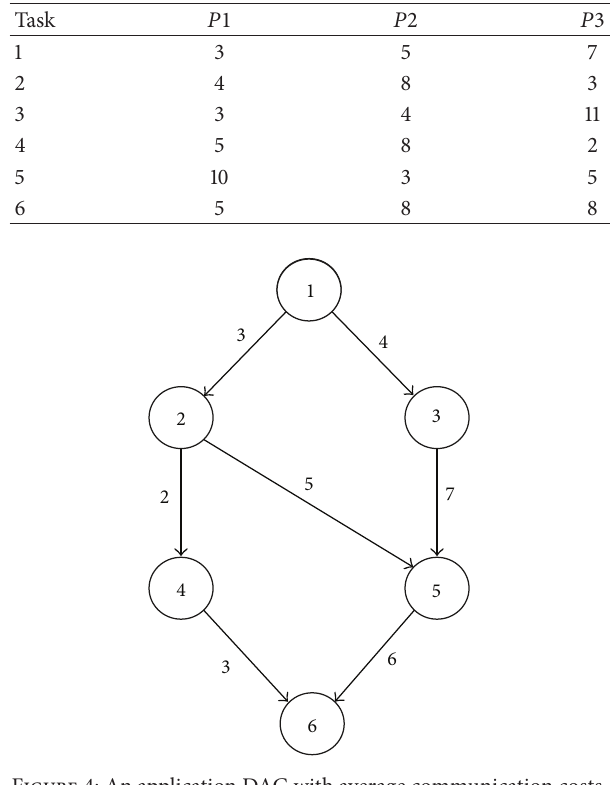
Table 1: Computation costs of tasks over computing resources.